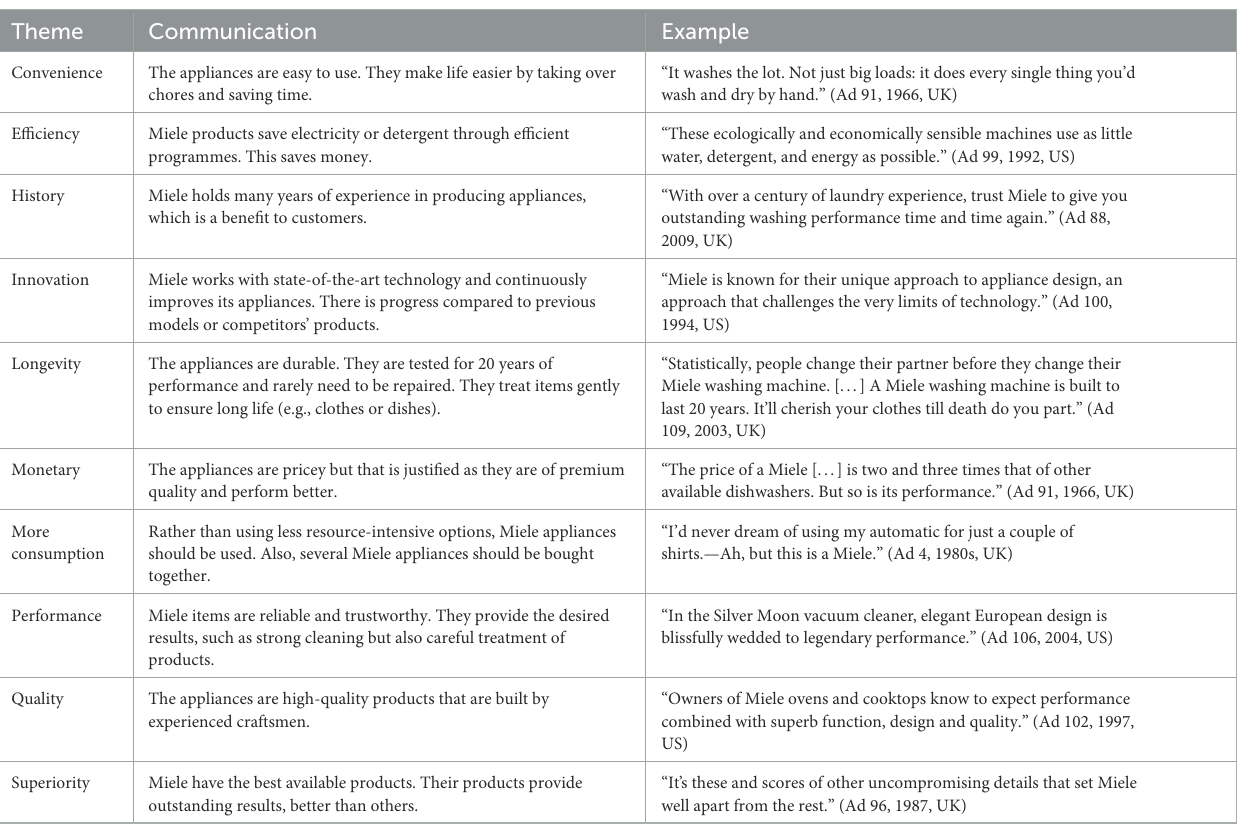
TABLE 5 Miele main themes in